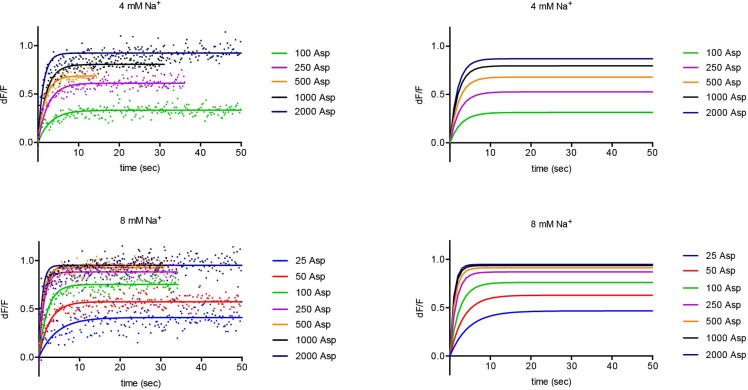
Experimental and simulated kinetics of L-asp binding to FM-P11WIFS.Left panels: representative data showing kinetics of L-asp binding in the presence of the indicated Na+ (mM) and L-asp (μM) concentrations. Data were fitted to single exponential functions. Color scheme is as follows: blue, 25 μM; red, 50 μM; green, 100 μM; purple, 250 uM; orange, 500 μM; black, 1000 μM; navy blue, 2000 μM L-asp. The simulations obtained using parameters from the global fitting of the data are shown on the right panels.